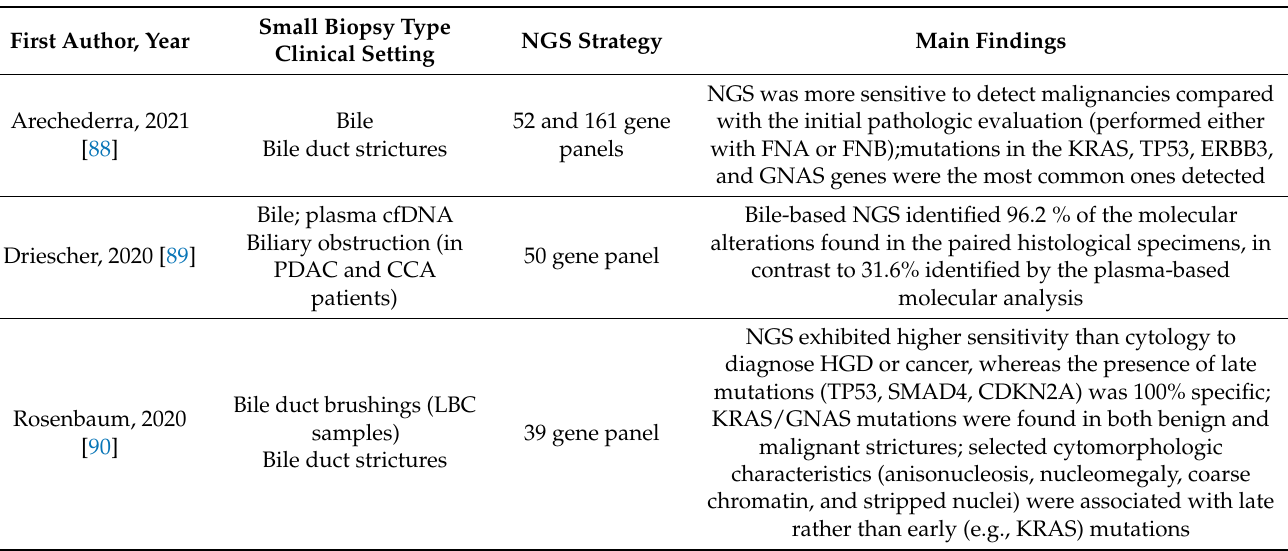
Table 2. The role of NGS performed on biliary small biopsies (bile duct brushings, forceps biopsy, and bile): doing more with